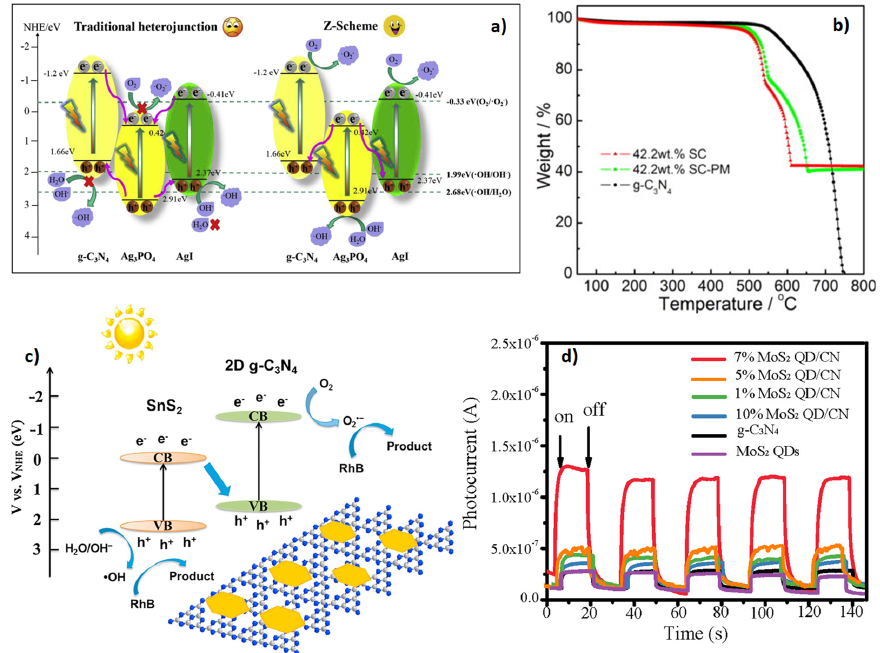
Figure 7. ROS formation catalyzed by a heterostructure. Reproduced from [137]. Copyright 2022, Elsevier.